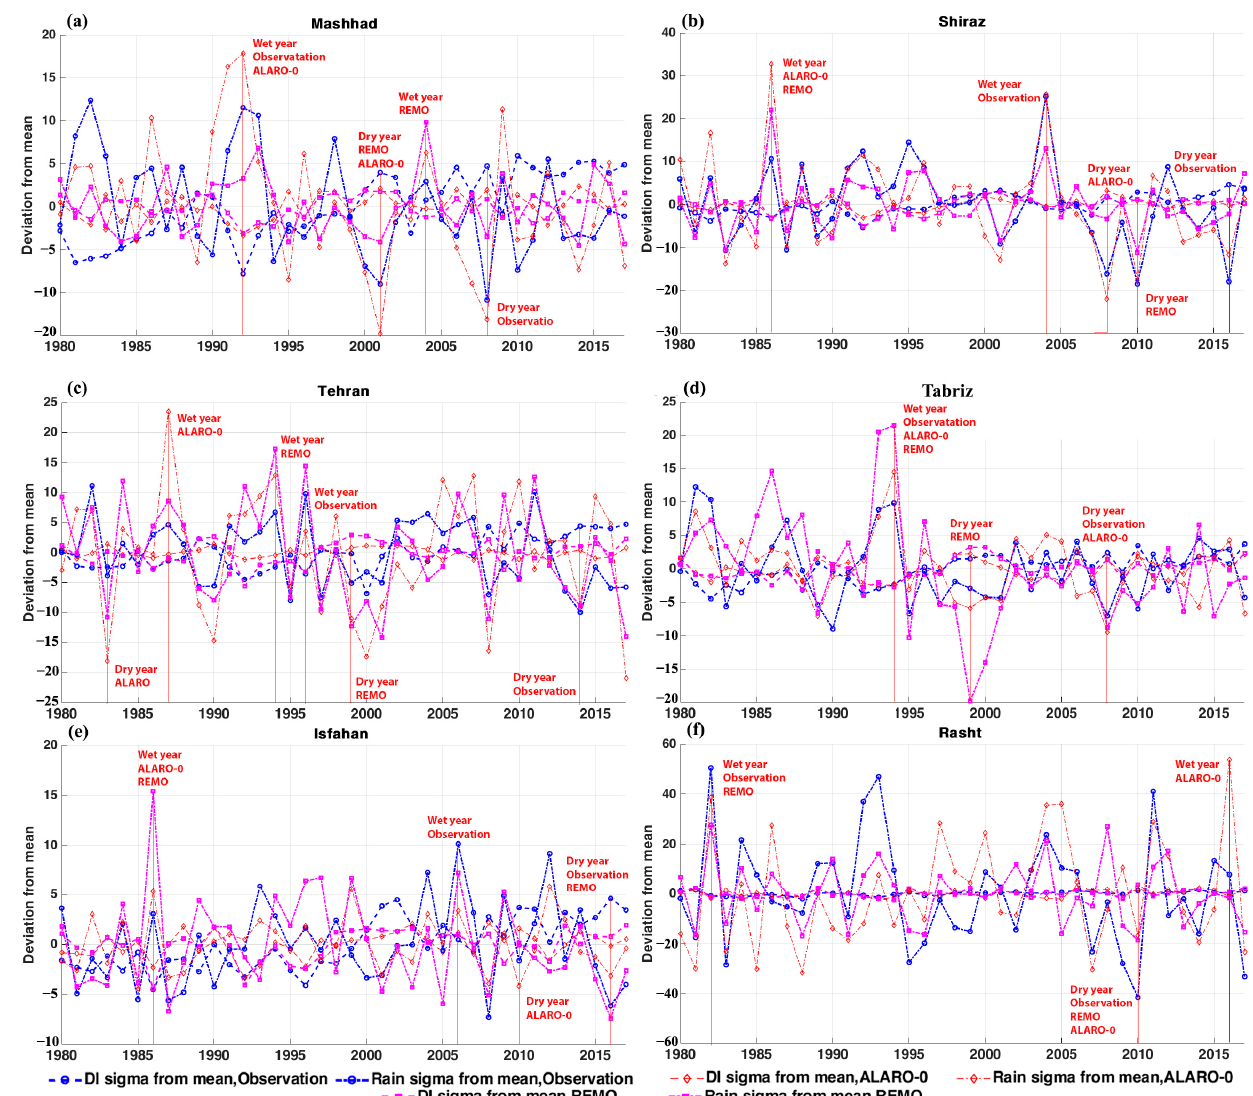
Figure 14. Deviation of individual years from means of wet and dry index comparing models with observation over six studied stations: Mashhad ( a ), Shiraz ( b ), Tehran ( c ), Tabriz ( d ), Isfahan ( e ) and Rasht ( f ) during 1980–2017.